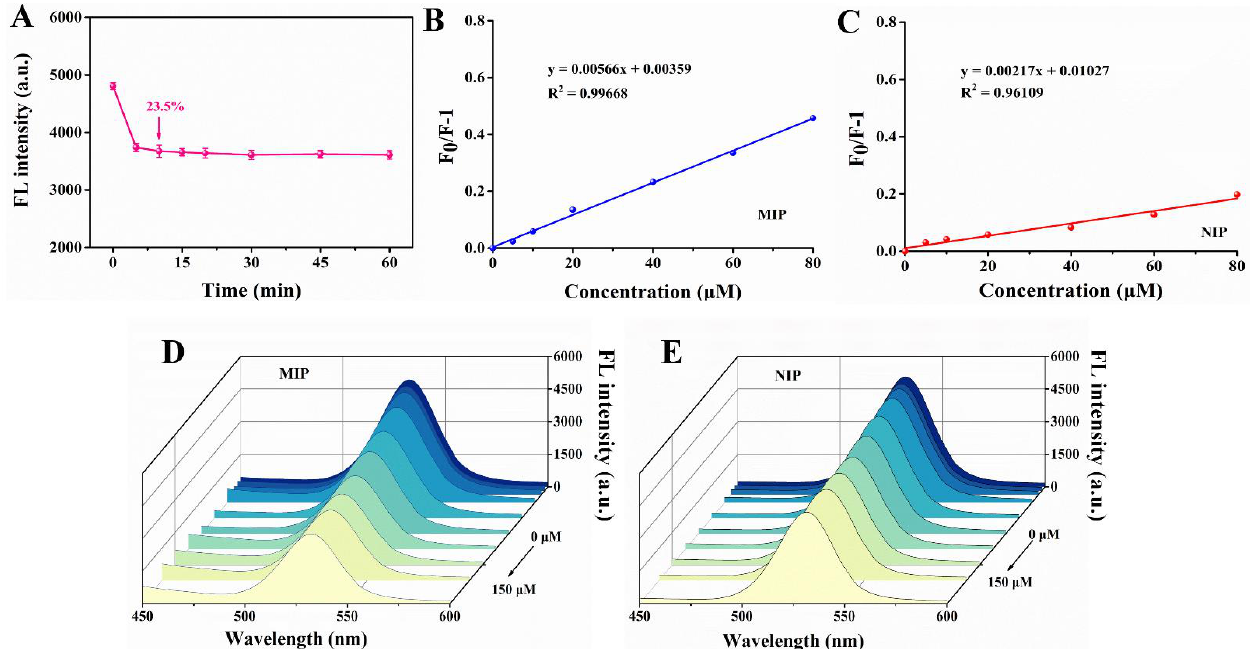
Figure 8. ( A ) Fluorescence response time of imprinted paper chip with 60 μM dimethoate. Linear response of fluorescence change of MIP ( B ) and NIP ( C ). The fluorescence changes of MIP ( D ) and NIP ( E ) at different concentrations of dimethoate (0, 5, 10, 20, 40, 60, 80, 100, 120 and 150 μM).